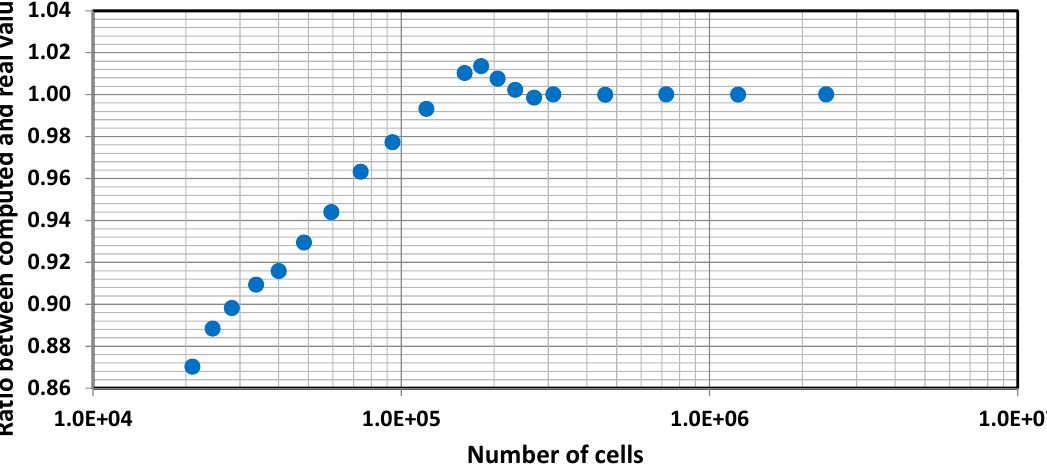
Figure 5. Analysis of the influence of the size of the mesh (size of the cells).